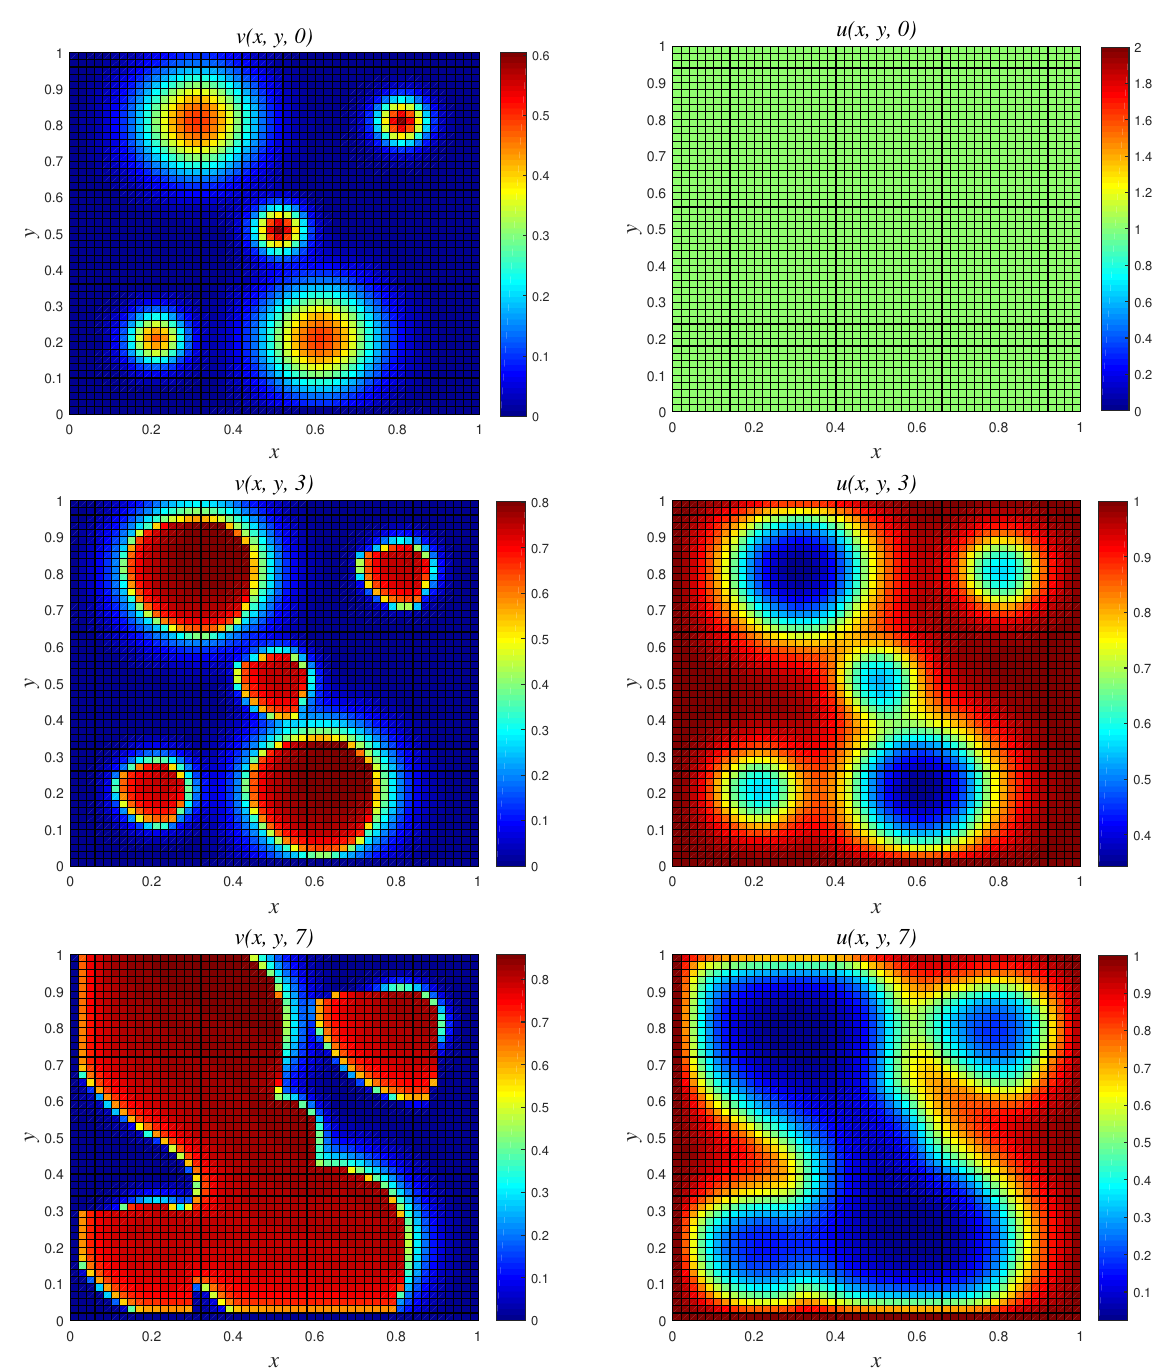
Figure 11. 3D plots of numerical solution vs. x vs. y using classical scheme at times t = 0,3 and 7. We used spatial step sizes h x = h y = 0.02 and time step k =